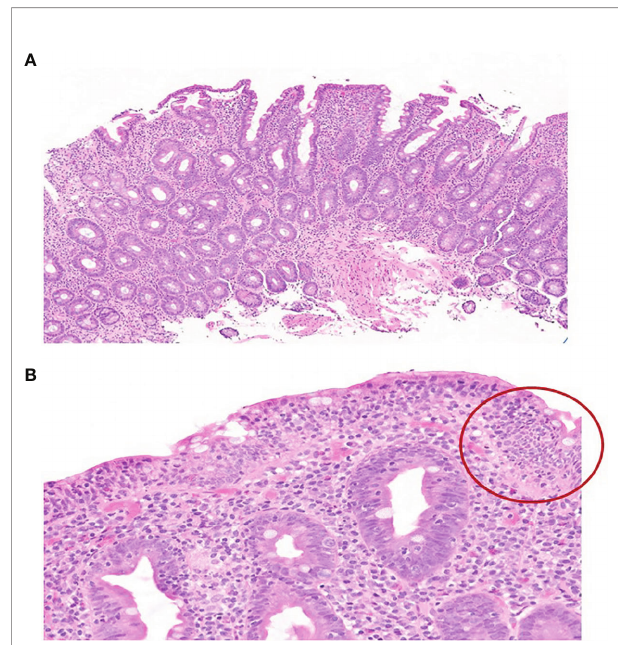
FIGURE 2 | (A) H&E-stained slide (×10) of duodenal biopsy demonstrating marked villous blunting, crypt hyperplasia, and expansion of lamina propria by lymphocytes and plasma cells. (B) H&E-stained slide (×10) of duodenal biopsy highlights the marked intraepithelial lymphocytosis (circled) without evidence of epithelial injury or neutrophils.